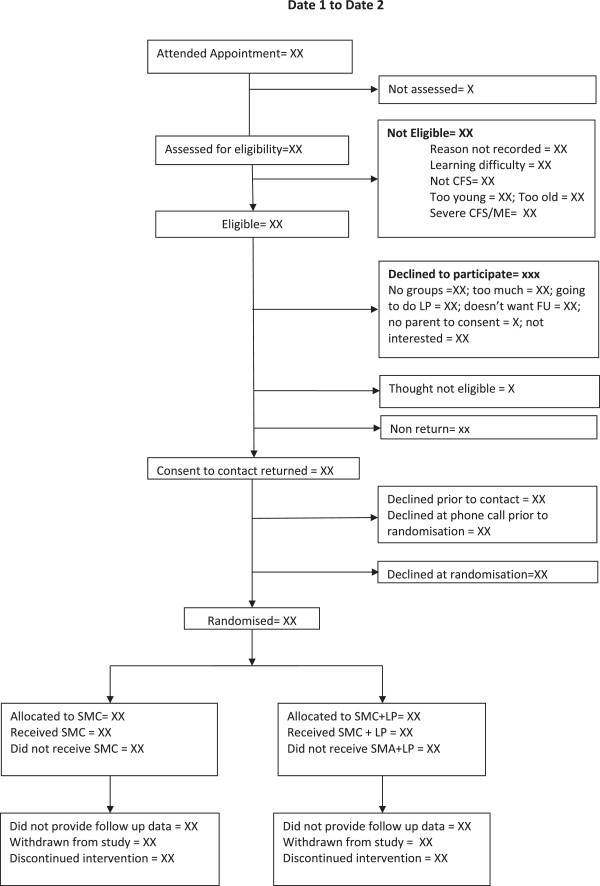
SMILE flow diagram.